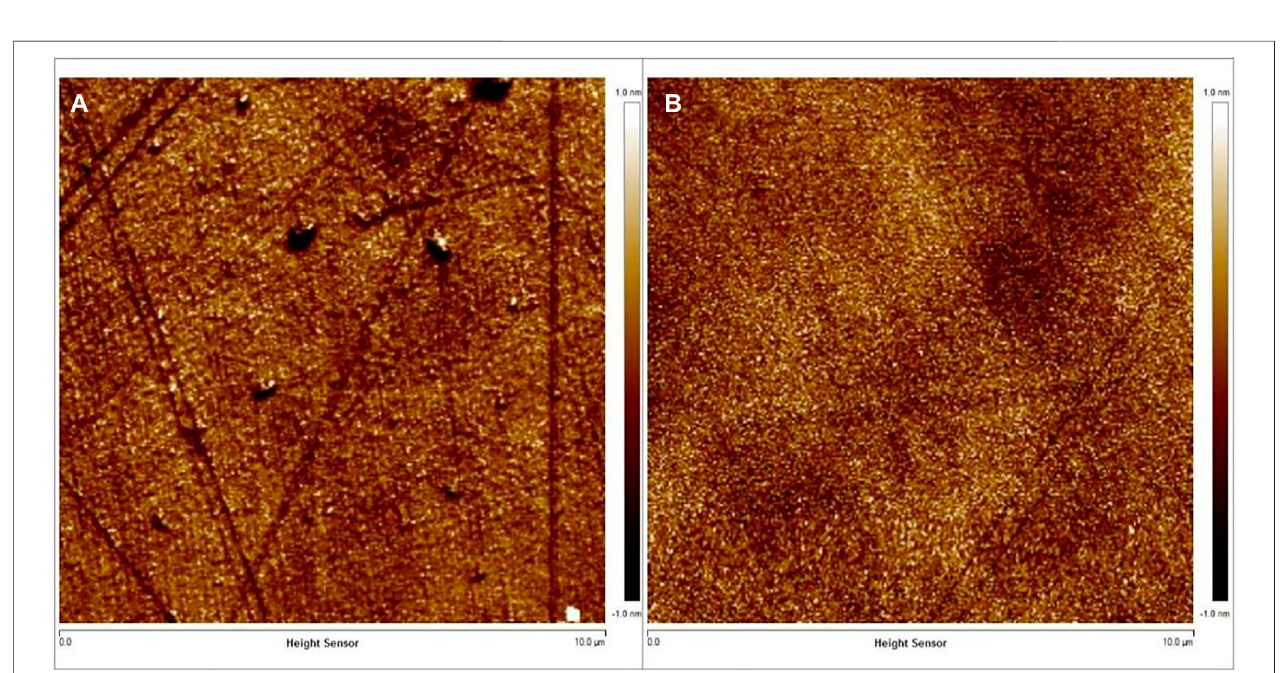
FIGURE 5 | AFM images of GaSb wafers under the polishing solution with dilution ratios of (A) 1:3 and (B) 1:20.